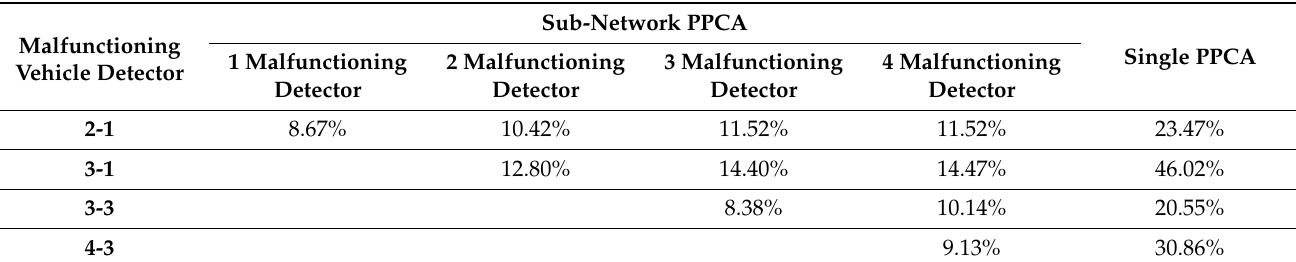
Table 1. Imputation error comparison between Sub-Network PPCA and Single PPCA for Scenario C .